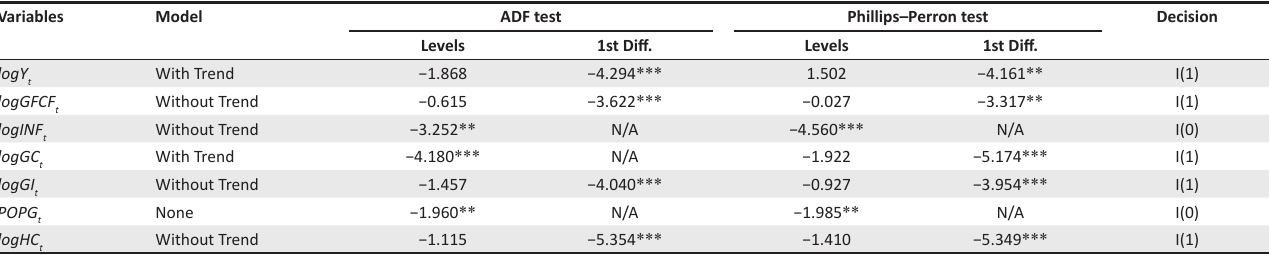
TABLE 3: Unit root test results. Variables